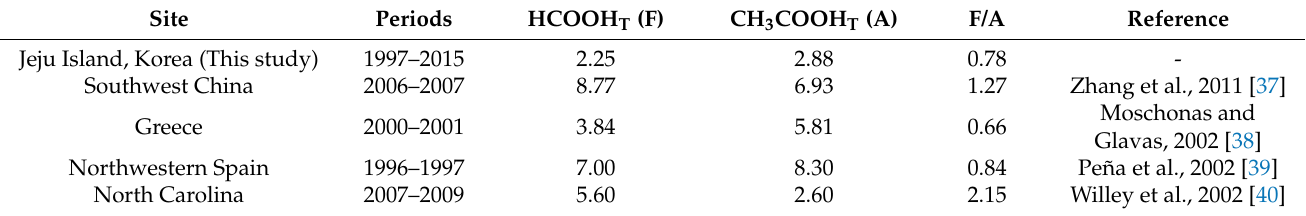
Table 4. Measured HCOOH T and CH 3 COOH T concentrations ( µ mol/L) in precipitation on Jeju Island and other areas. Site Periods HCOOH T (F) CH 3 COOH T (A) F/A Reference